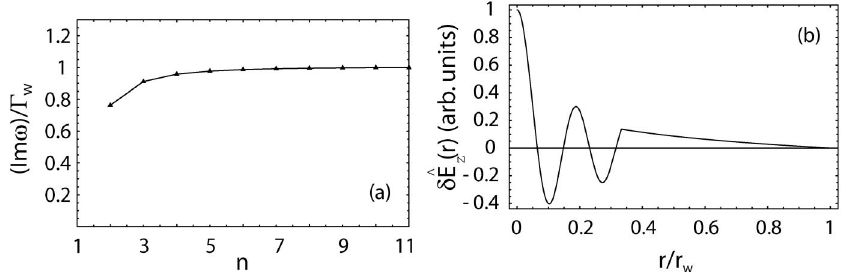
(cid:1) r (cid:2) versus r=r z (cid:7) 0 p